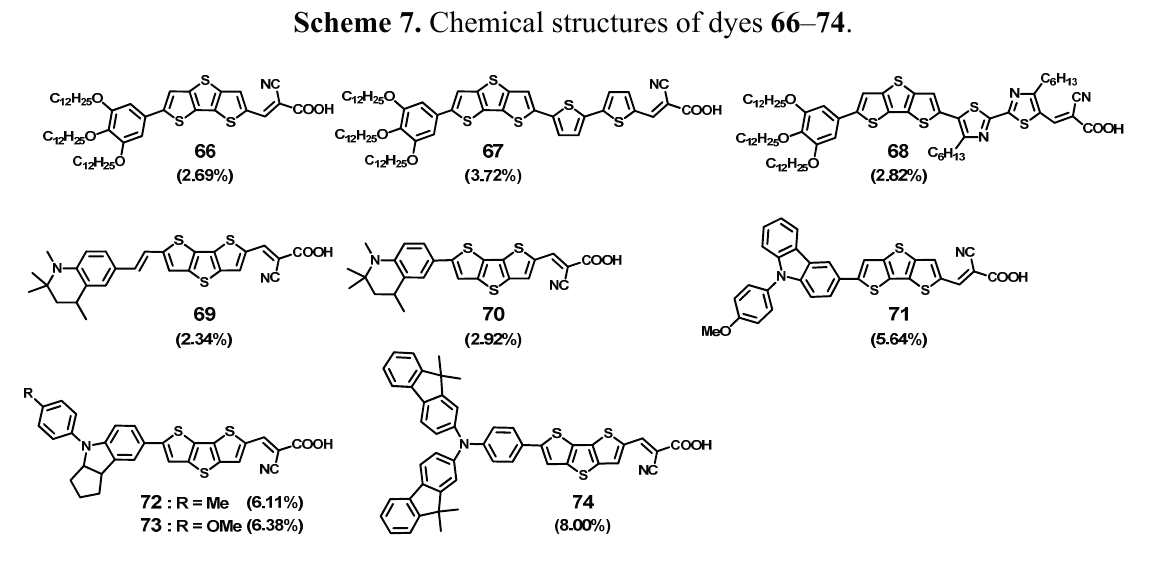
Table 2. Photophysical and photovoltaic performances of dye-sensitized solar cells (DSSCs) based on fused-thiophene containing organic